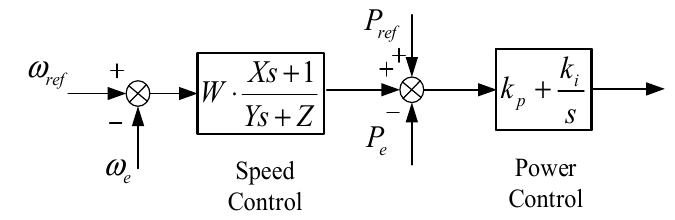
Figure 2. Integrated speed and power control.